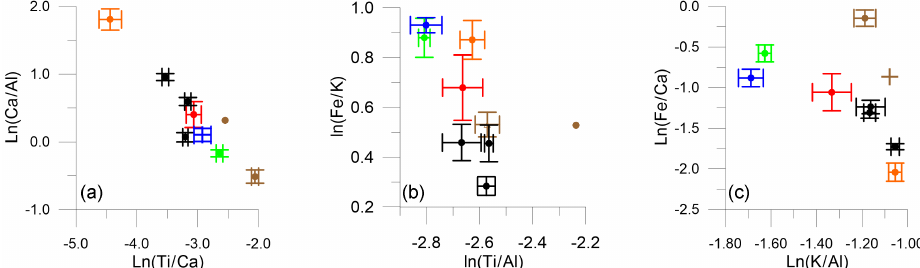
Figure 2. Scatter plots of average ± standard deviation of (a) ln(Ca / Al) versus ln(Ti / Ca); (b) ln(Fe / K) versus ln(Ti / Al); and (c) ln(Fe / Ca) versus ln(K / Al). Colours refer to samples from the coast and inner shelf (brown), outer shelf and upper slope (black), relict outer shelf sediment (orange), upper slope – SACW (green), middle slope – IWBC (red) and middle slope – DWBC (blue).